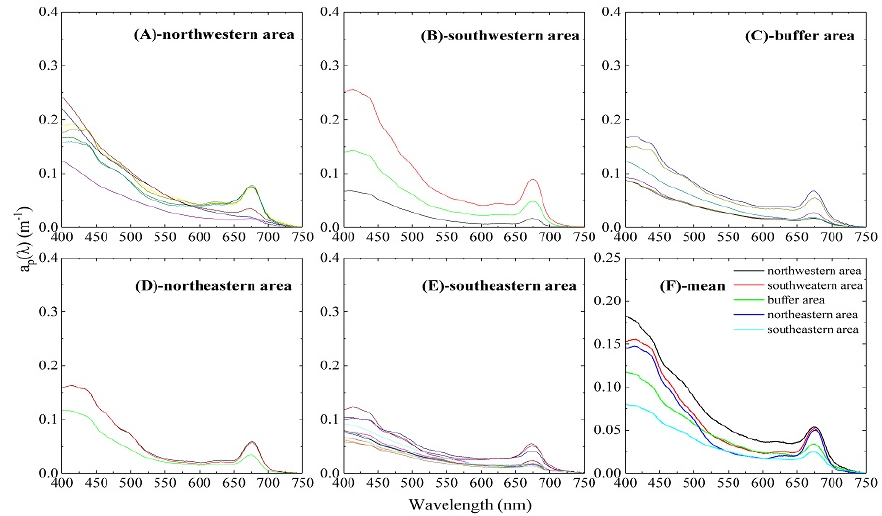
Figure 4. ( A – E ) Total particle absorption spectra in different regions of the summer season in Lake Qiandaohu; and ( F ) the average total particle absorption spectra from each area.